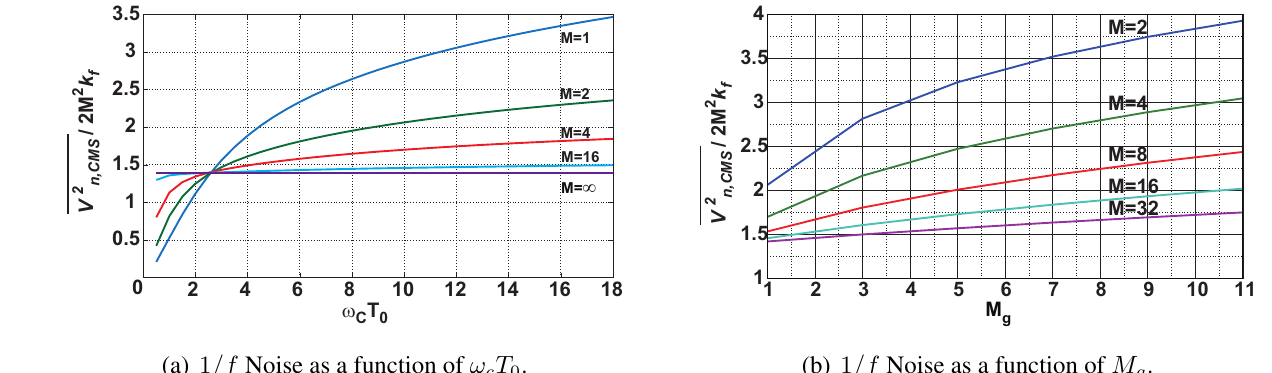
(b) 1 =f Noise as a function of M g